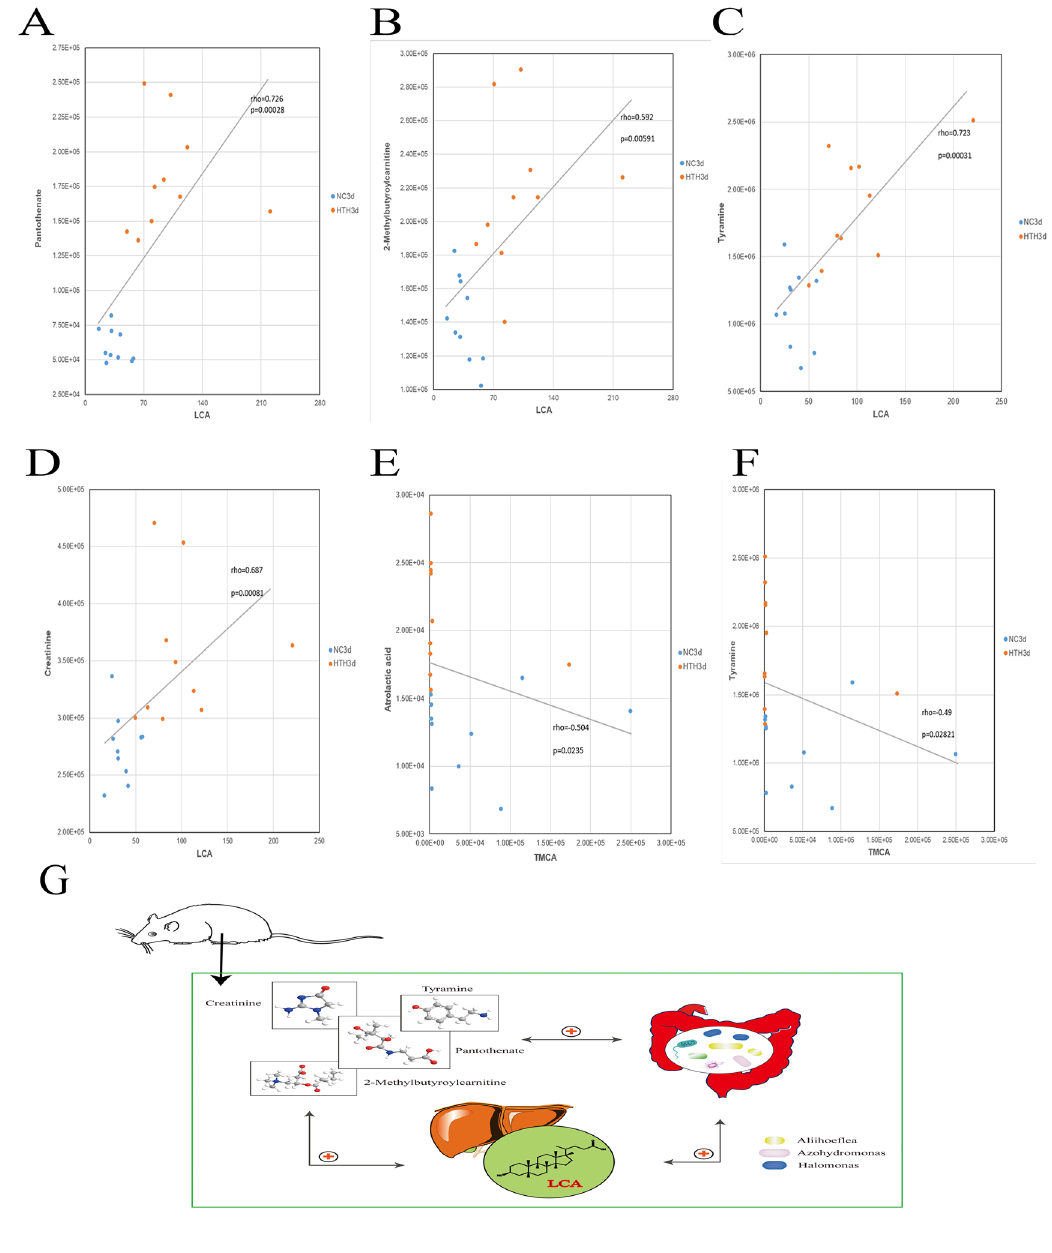
Figure 5. ( A – F ): The scatterplot illustrates the statistical association ( p < 0.05) of altered mouse liver bile acids with some typical plasma metabolites. ( G ) Diagram of the interaction between plasma metabolites, intestinal microorganisms, and bile acids. “ + ”Stands for positive correlation. Two-way arrows represent